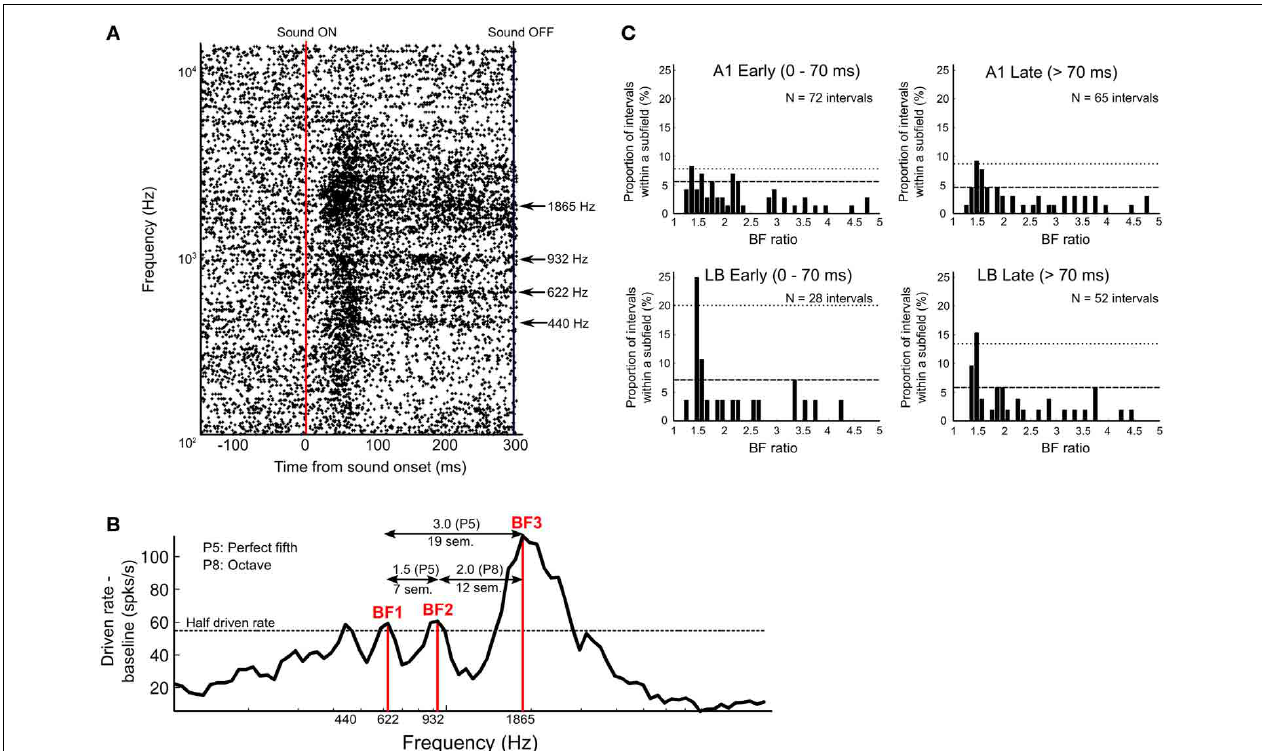
FIGURE 5 | Response of multi-peaked neurons. (A) Raster plots of single-unit activity in an example neuron from area ML with multi-peaked tuning (bin width 1ms). Plots are aligned to sound onset (vertical red line) in response to 84 tones presented in semitone-steps between 110Hz (A2) and 13.3kHz (G#9). Sound offset is indicated by vertical black line at far right. Y-axis indicates frequency (Hz) of pure-tone stimuli on a log scale. The neuron responded to four distinct frequency bands (440, 622, 932, and 1865Hz), which are indicated by arrows. (B) Rate tuning curve of the multi-peaked neuron shown in (A) based on peak response magnitude during the entire duration of the sound (normalized by subtracting baseline activity and 5-point smoothing). Four peaks above the half driven rate (defined as 50% of the highest normalized peak firing rate, here indicated as a dotted line) were detected, and we chose the three highest peaks as best frequencies (BF1, BF2, BF3) to analyze the interval relations of multiple peaks. In this neuron, the frequency interval ratios of the three